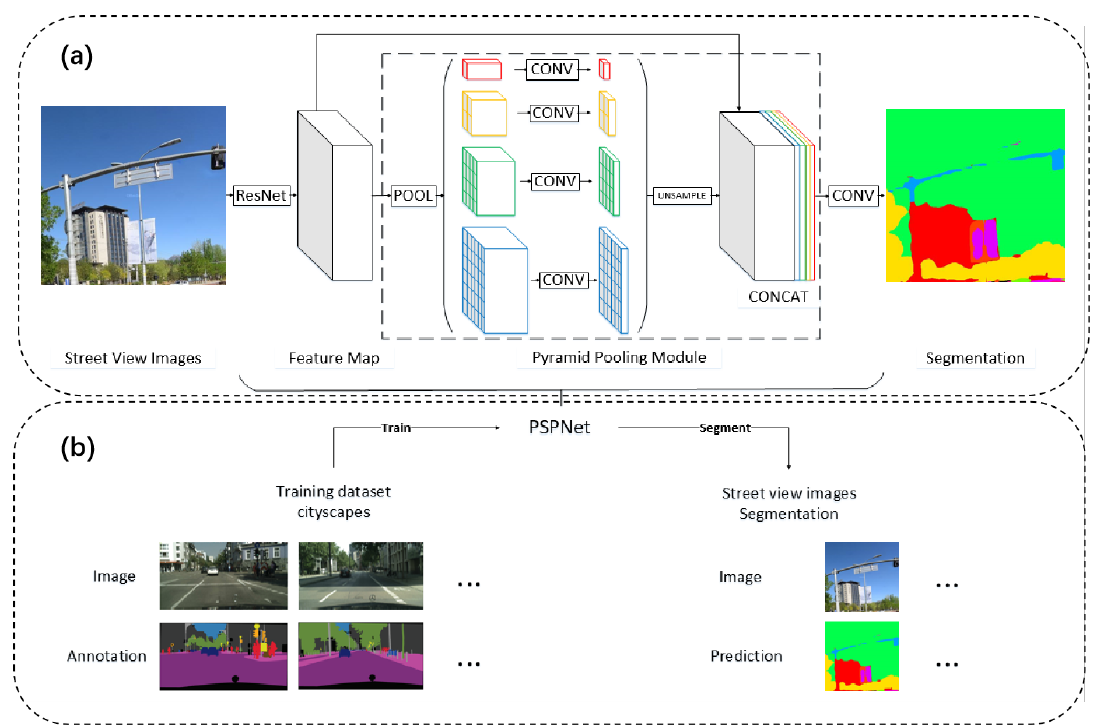
Figure 2. The architecture of PSPNet [30] ( a ) and the flow of street view image segmentation ( b ).